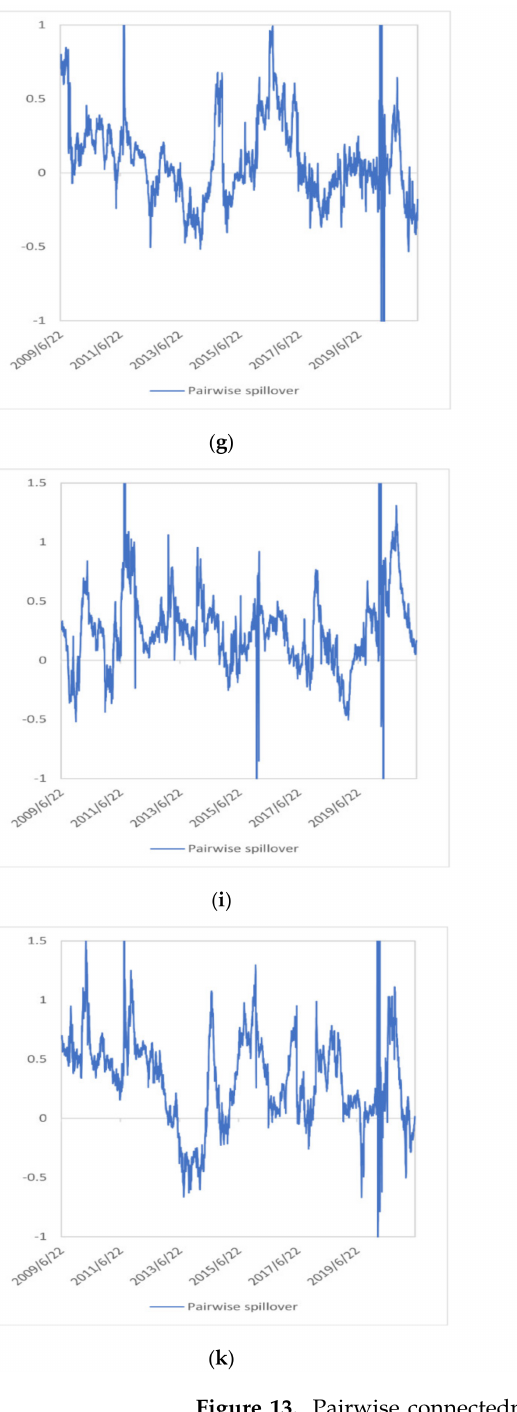
Figure 13. Pairwise connectedness between NEX and other variables in price volatility system. ( a ) pairwise connectedness between NEX and MSCI. ( b ) frequency decomposition of pairwise con- nectedness between NEX and MSCI. ( c ) pairwise connectedness between NEX and PSE. ( d ) frequency decomposition of pairwise connectedness between NEX and PSE. ( e ) pairwise connectedness be- tween NEX and WTI. ( f ) frequency decomposition of pairwise connectedness between NEX and WTI. ( g ) pairwise connectedness between NEX and Brent. ( h ) frequency decomposition of pairwise connectedness between NEX and Brent. ( i ) pairwise connectedness between NEX and EUA. ( j ) fre- quency decomposition of pairwise connectedness between NEX and EUA. ( k ) pairwise connectedness between NEX and 10YTN. ( l ) frequency decomposition of pairwise connectedness between NEX and